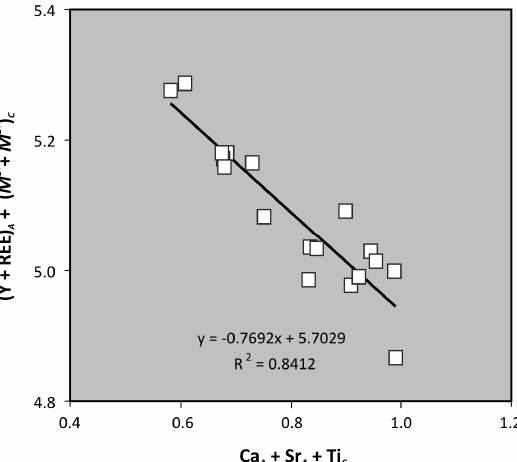
Figure 5. Correlation between A - and C -site cations (apfu) in chevkinite-Ce from Pinciná.